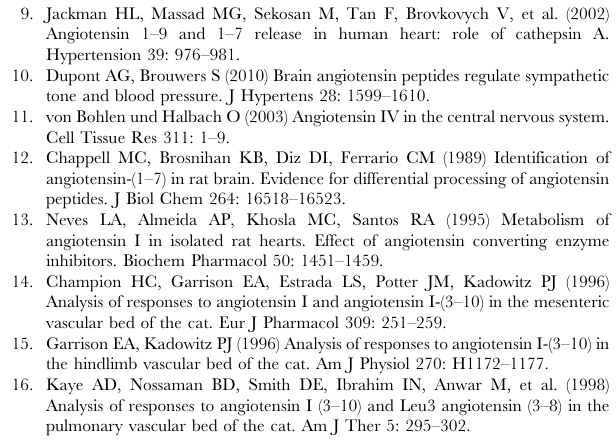
arrows. Control: ANG-1-10 incubated for 24 h with Sepharose- beads H without immobilized proteins. (TIFF) Figure S2 Processing of ANG-1-10 by immobilized rat plasma proteins. ANG-1-10 (10 2 5 M) was incubated with immobilized rat plasma proteins. Reaction products were detected by MALDI-MS after 0 h, 1 h, 3 h and 8 h. MALDI-MS signals corresponding to angiotensin peptides are marked by arrows. Control: ANG-1-10 incubated for 24 h with Sepharosebeads H without immobilized proteins. (TIFF) Figure S3 Processing of ANG-1-10 by immobilized human female plasma proteins. ANG-1-10 (10 2 5 M) was incubated with immobilized human female plasma proteins. Reaction products were detected by MALDI-MS after 0 h, 3 h, 4 h and 8 h. MALDI-MS signals corresponding to angiotensin peptides are marked by arrows. Control: ANG-1-10 incubated for 24 h with immobilized heat inactivated plasma proteins. (TIFF) Figure S4 Identification of angiotensin peptides by tandem mass spectrometry. The reaction products A) ANG-1-9, B) ANG-1-8, C) ANG-1-7, D) ANG-2-10, E) ANG-3- 10, F) ANG-4-10, G) ANG-5-10 and H) ANG-6-10 that were generated after incubation of ANG-1-10 with human immobilized plasma proteins were identified by LC/ 2 ESI-IT-MS/MS. Relating MS/MS spectra with assigned b- and y-fragment ions (dashed lines) and the deduced peptide sequence are shown. (TIFF) Figure S5 Processing of ANG-2-10 by immobilized human plasma proteins. ANG-2-10 (10 2 5 M) was incubated with immobilized human plasma proteins. Reaction products were detected by MALDI-MS after 8 h. MALDI-MS signals corre- sponding to angiotensin peptides are marked by arrows. Figure S6 Processing of ANG-1-10 by immobilized human plasma proteases in the presence and abscence of protease inhibitors. ANG-1-10 (10 2 5 M) was incubated with human plasma proteins in presence of 200 m M AEBSF, chymostatin, 100 m M EDTA and absence of any inhibitor. Reaction products were analyzed by SRM-MS after 6 h and the areas under the curves (AUC) of ANG-2-10, ANG-3-10, ANG-4-